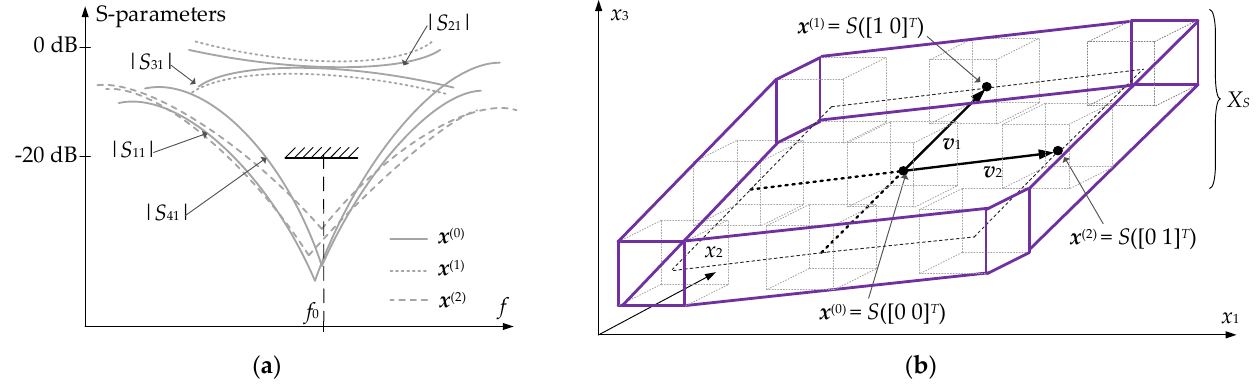
Figure 4. Yield optimization using performance-driven surrogate modeling concept [45]: ( a ) S -parameters of a microwave coupler at the nominal design x (0) , design x (1) (spoiled power split), and design x (2) (improved − 20 dB bandwidth); only selected S -parameters are shown for x (1) (| S 21 |, | S 31 |) and x (2) (| S 11 |, | S 41 |) for clarity. The designs x (1) and x (2) determine the important directions from the point of view of yield manipulation; ( b ) Designs x (0) , x (1) , and x (2) form surface S ( t ) parameterized by vector t = [ t 1 t 2 ] T . The union of intervals S I ( t ) for − 1 ≤ t 1 , t 2 ≤ 1 becomes the domain X S of the surrogate model.